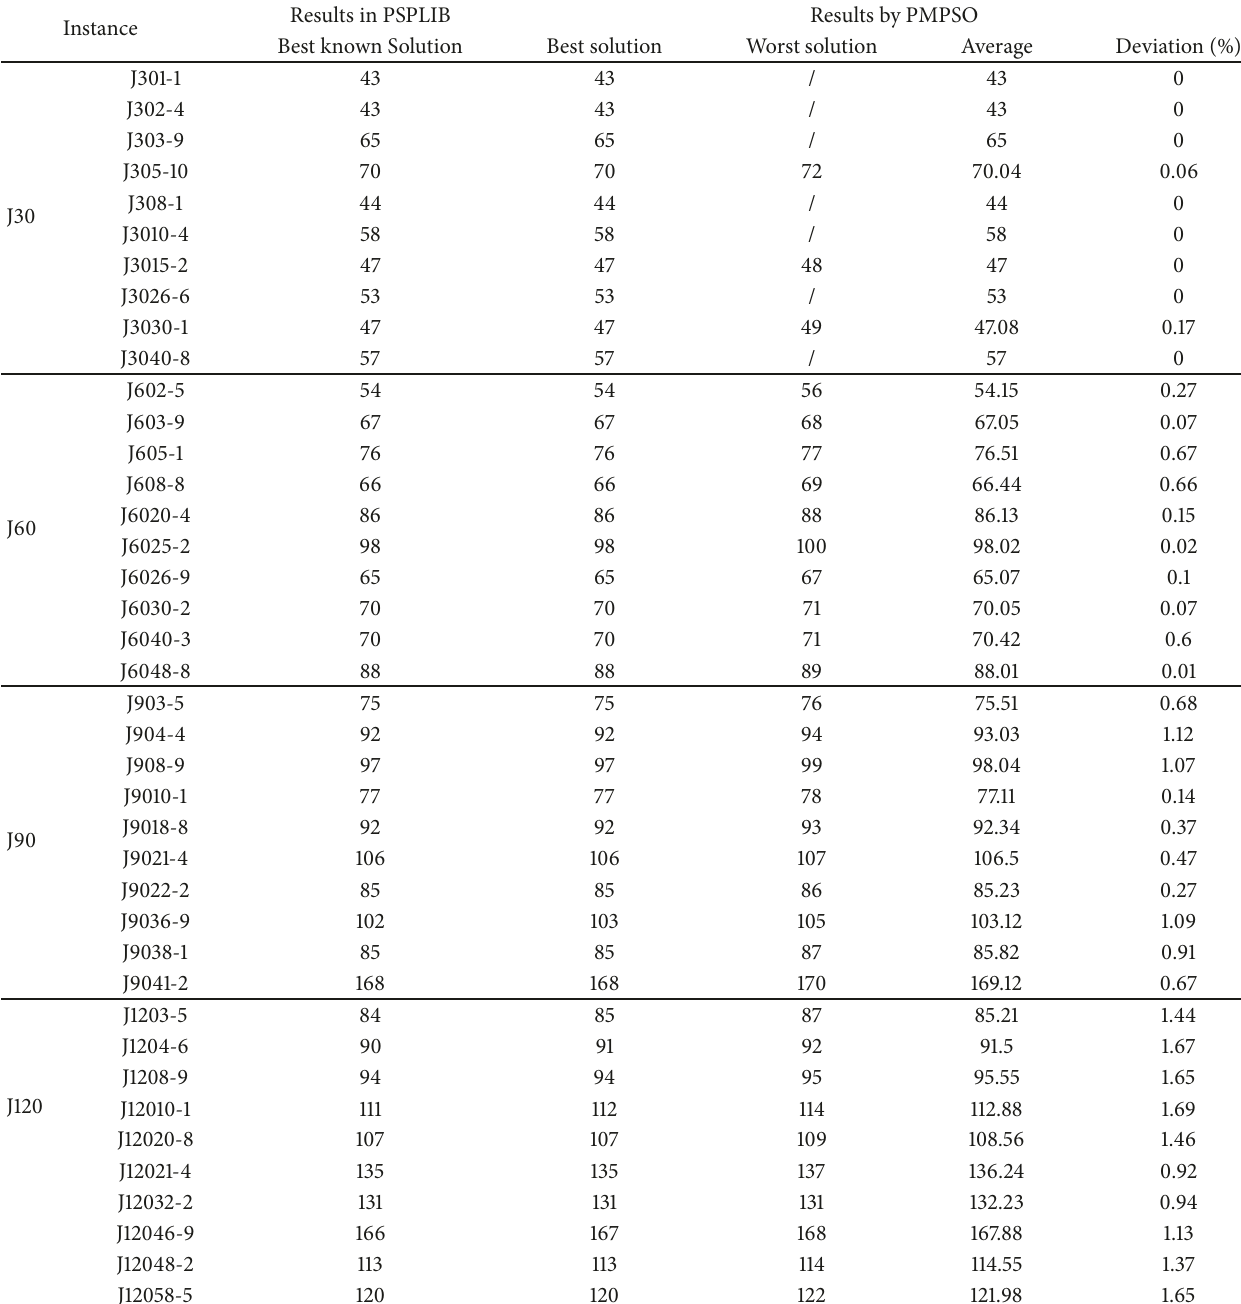
Table 1: Solutions of the selected instances.